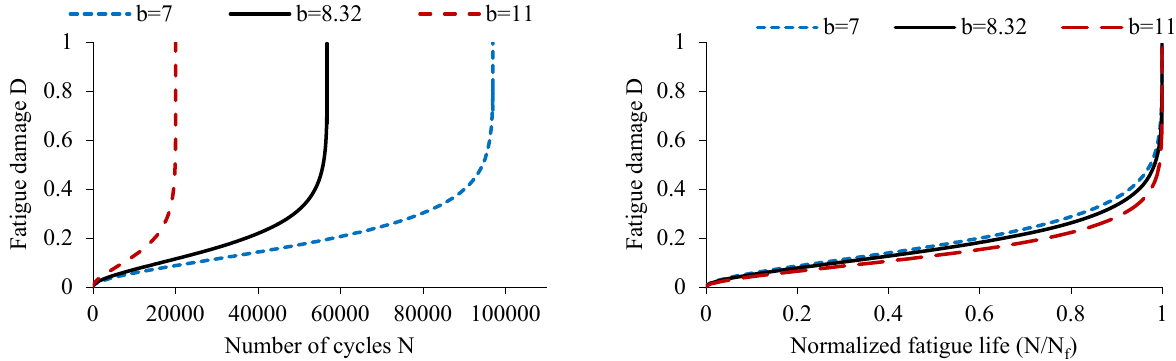
the fi rst stage, resulting in a decrease in the fatigue life of the composite specimen. Figure 8. In fl uence of parameter ( ) b on damage evolution. Figure 8. Influence of parameter ( b ) on damage evolution.